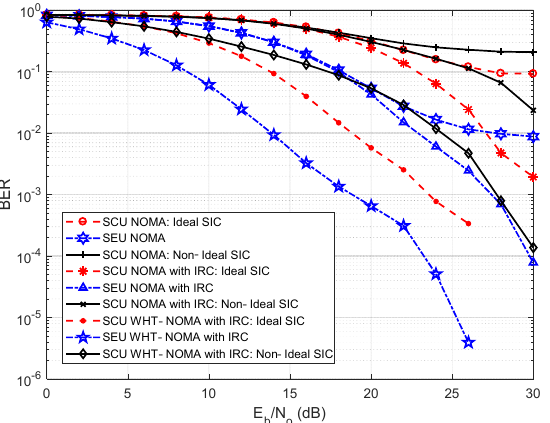
Figure 17. BER performance with IRC using 8–QAM modulation; NOMA vs. WHT–NOMA, power